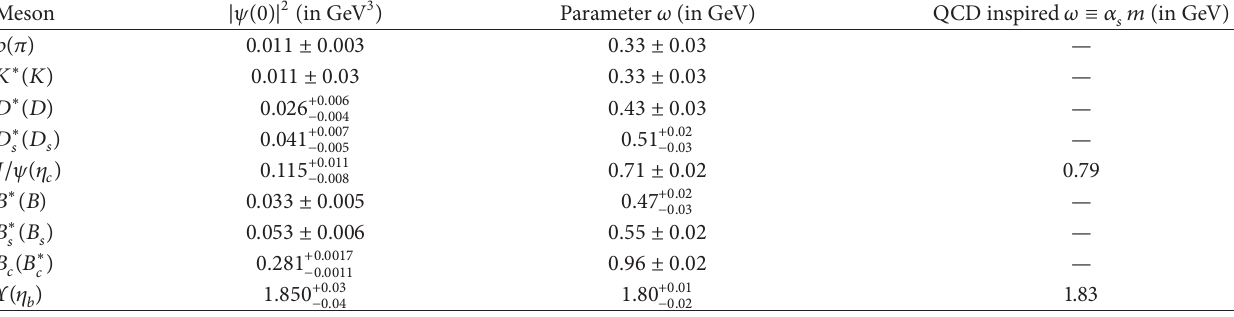
Table 7: |𝜓(0)| 2 and 𝜔 for vector and pseudoscalar mesons.